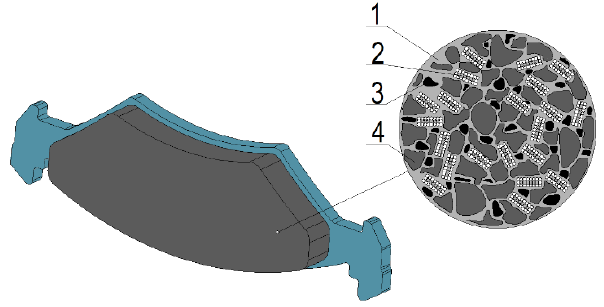
Figure 3: Brake pad friction material structure: 1 - binder, 2 - rein- forcement, 3 - filler, 4 -